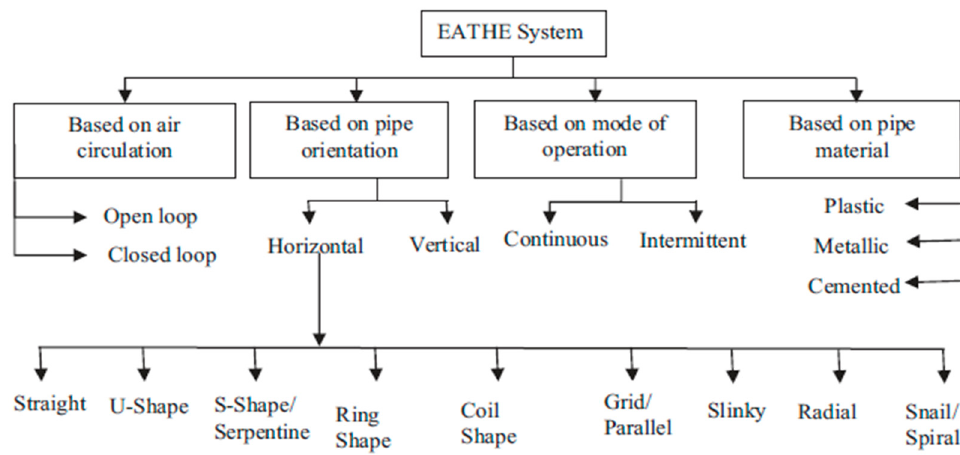
Figure 1. Classification of EAHX systems.